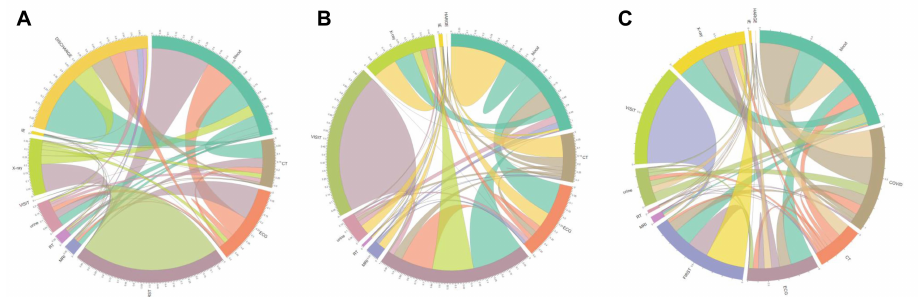
Figure 3. Chord diagram of process changes in the overall ED patients. The color refers to the next process, to which the patient moved. The number refers to the rate of patients who underwent the process. Visit: time of the first visit to the ED. ( A ) Phase 1, ( B ) Phase 2-CNTG, ( C ) Phase 2-CTG. First: triage; IE: interventions and endoscopy; COVID-19: coronavirus disease; PCR: polymerase chain reaction; RT: nasal and sputum sample-based respiratory rest; ECG: electrocardiography; Blood: blood sample-based laboratory tests; CT: computed tomography; Discharge: time when the discharge order or the admission order was